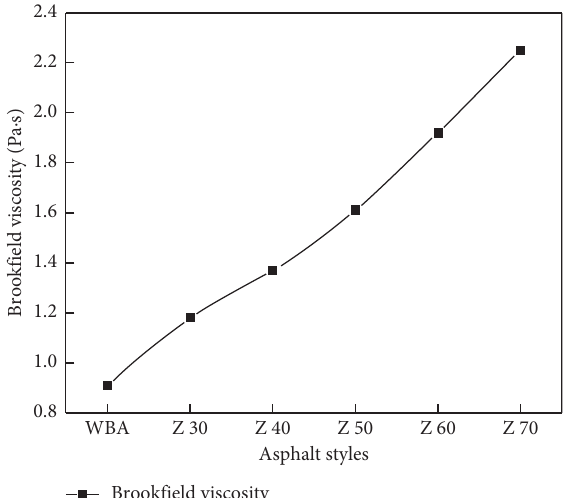
Figure 5: The relationship between asphalt and Brookfield viscosity at 120 ° C. ∗ Note: Z30, Z40, Z50, Z60, and Z70 means that 30% by weight of total asphalt, etc., of aged asphalt was blended with